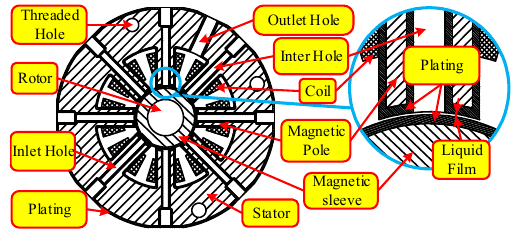
Figure 2. Cutaway view of the Radial Unit.